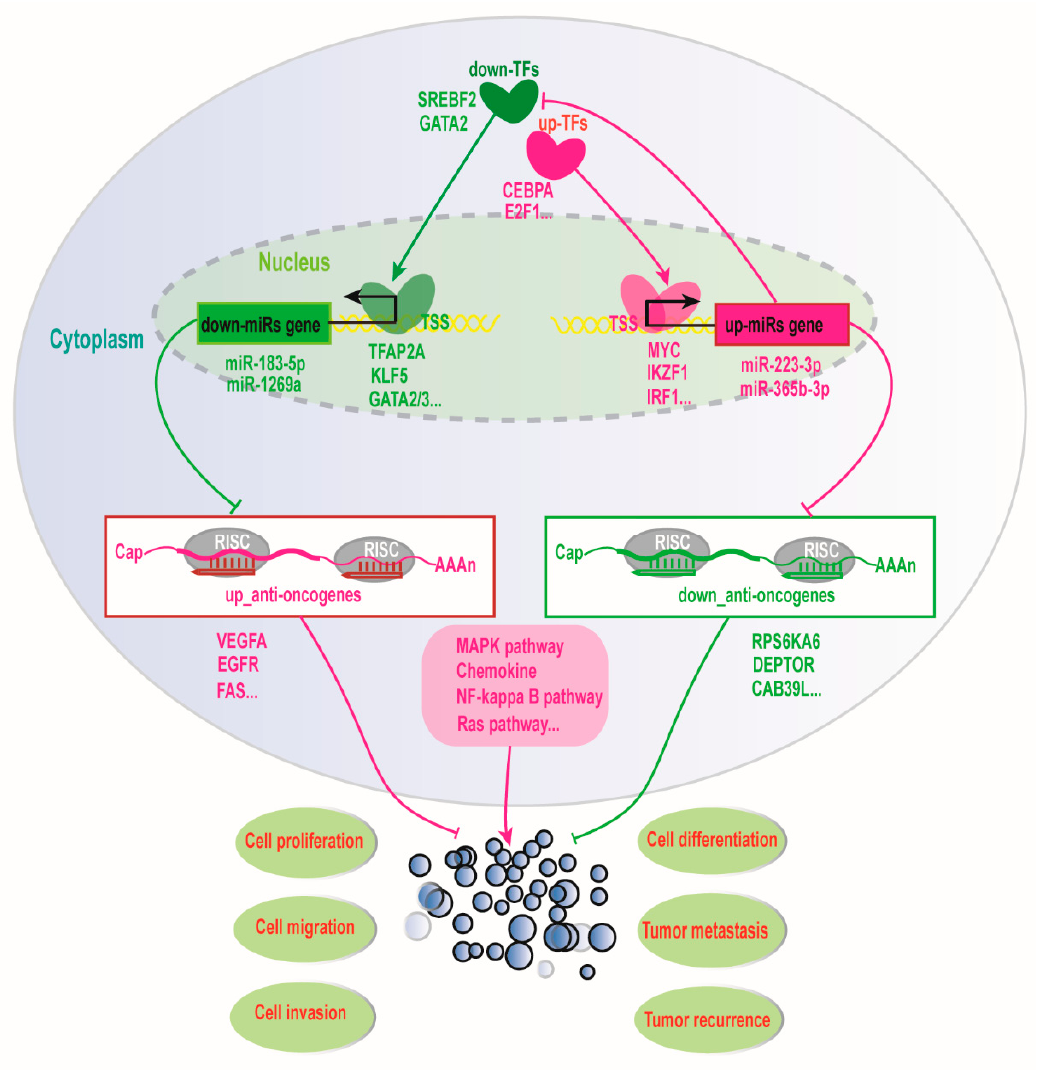
Figure 10. The molecular mechanism of the interplay between transcription factors and miRNAs improving the prognosis of ccRCC patients. The red represents an up-regulation of gene expression and the green represents down-regulation of gene expression. The sharp arrow represents activation and the flat arrow represents inhibition.